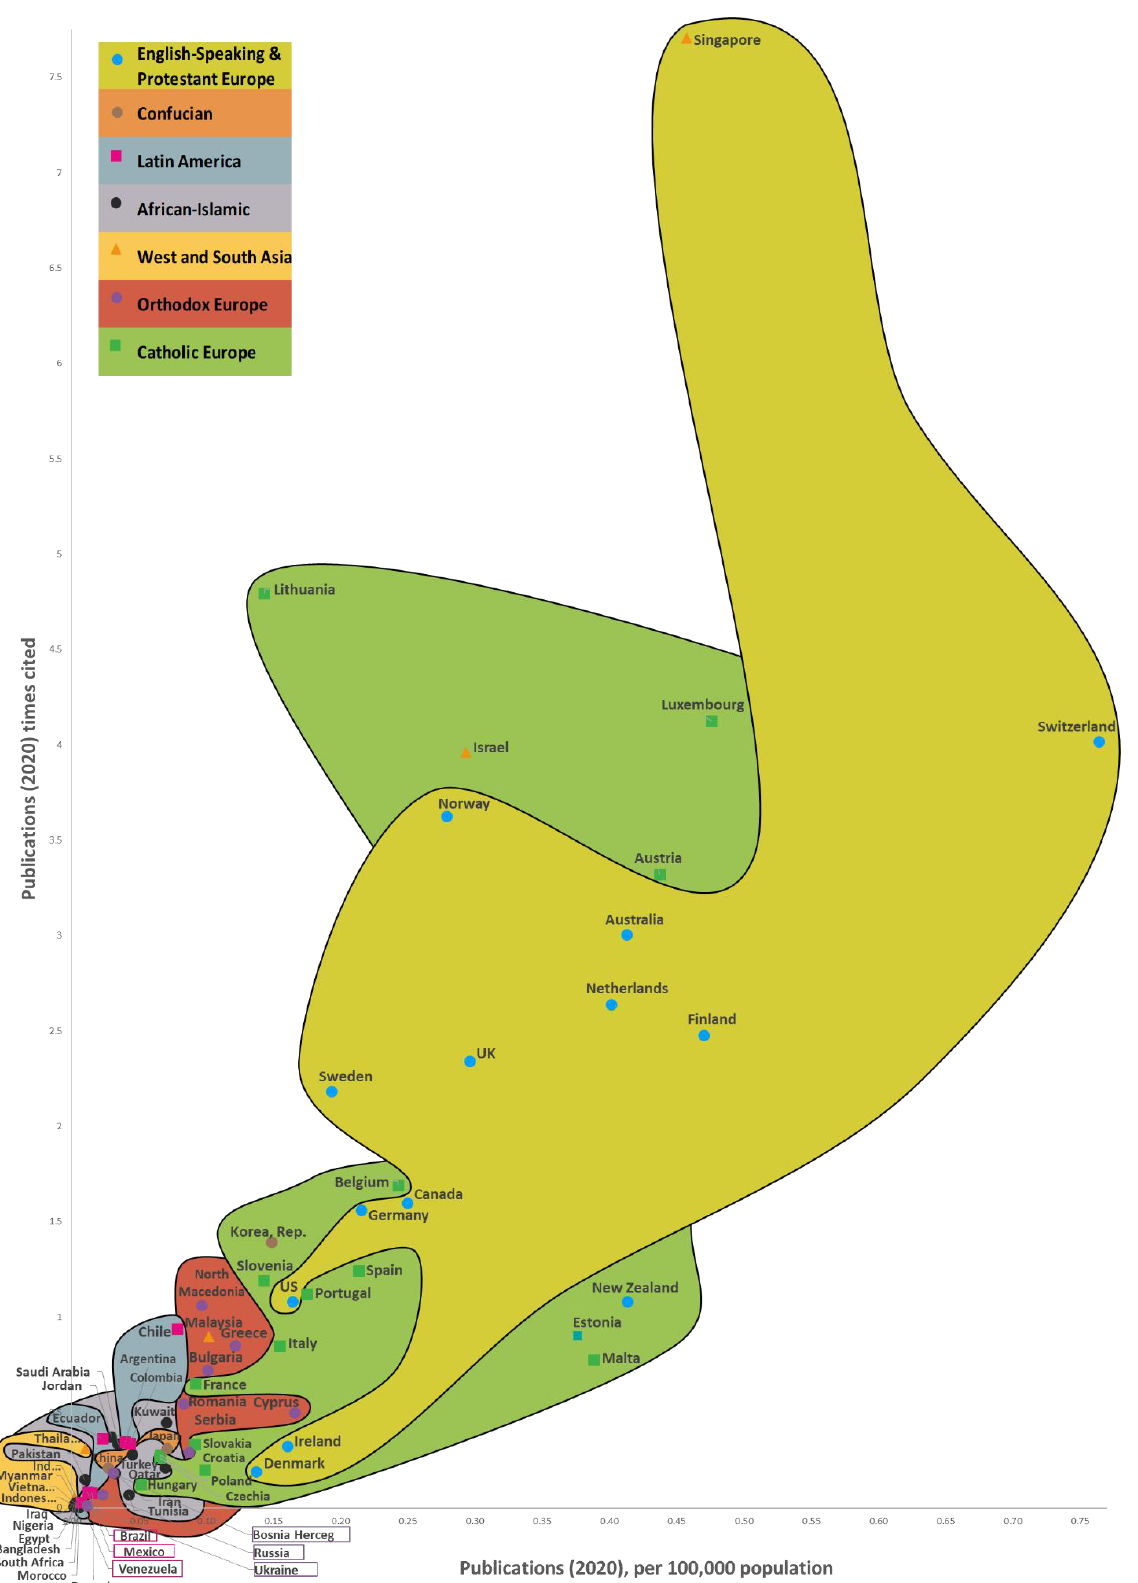
Figure 14. CSP map showing the number of articles on AFFECT recognition and the numbers of citations in Web of Science journals with impact factor.